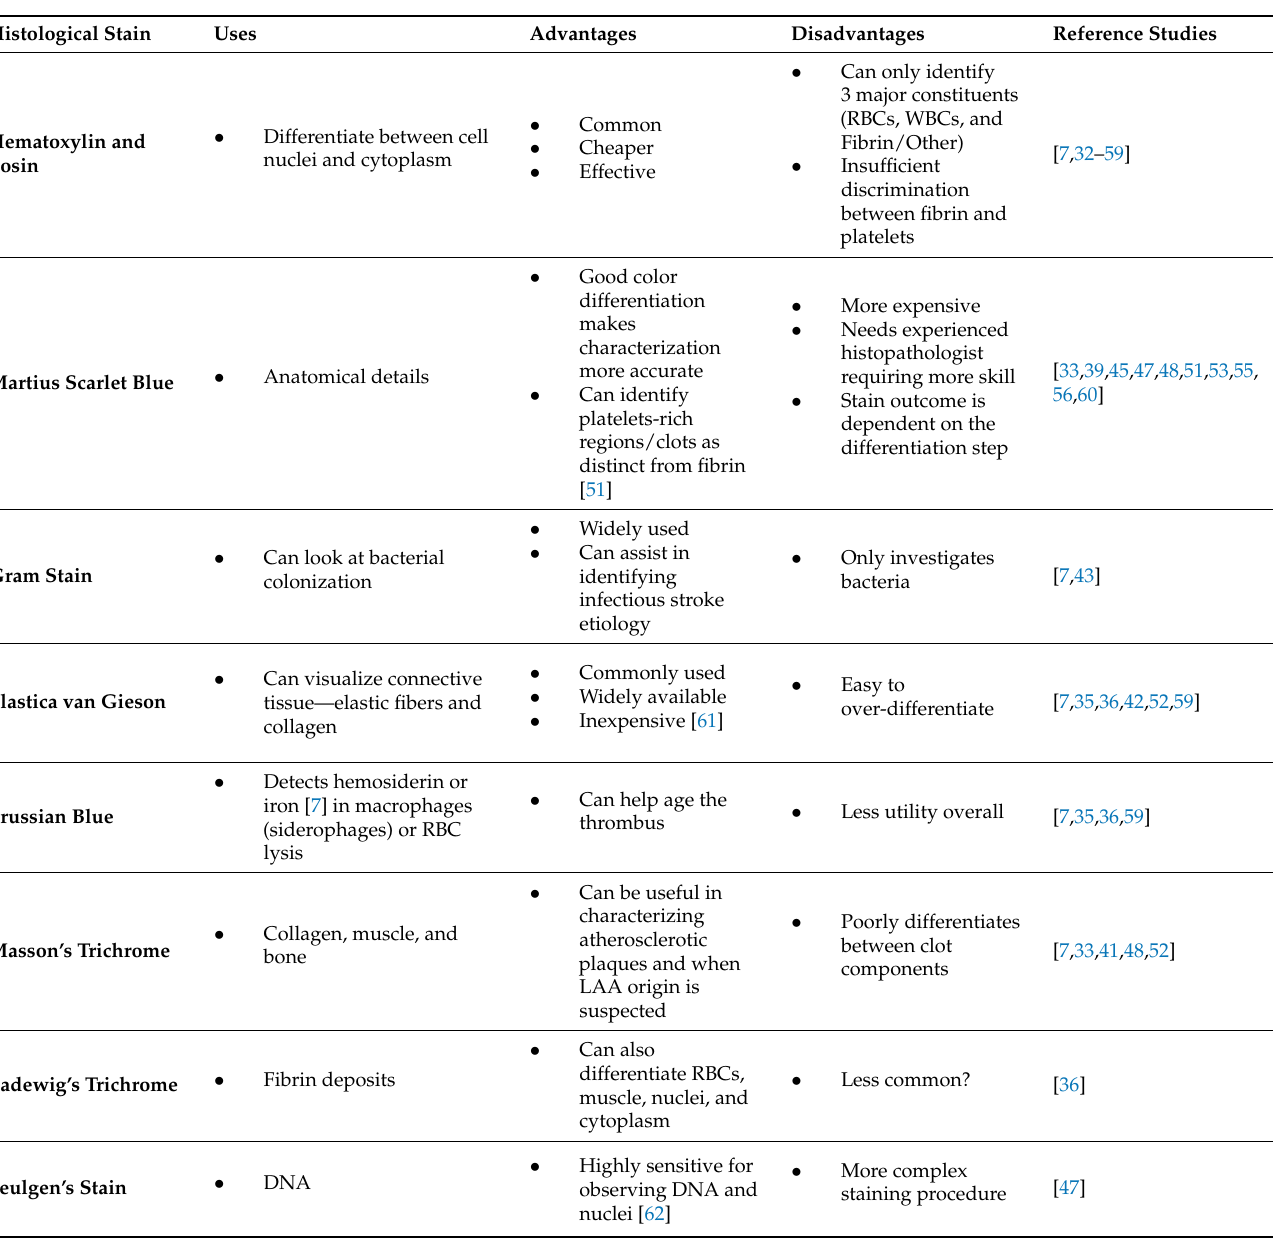
Table 1. Clot histology stains and immunohistochemical analyses used by various studies: Uses, advantages, and